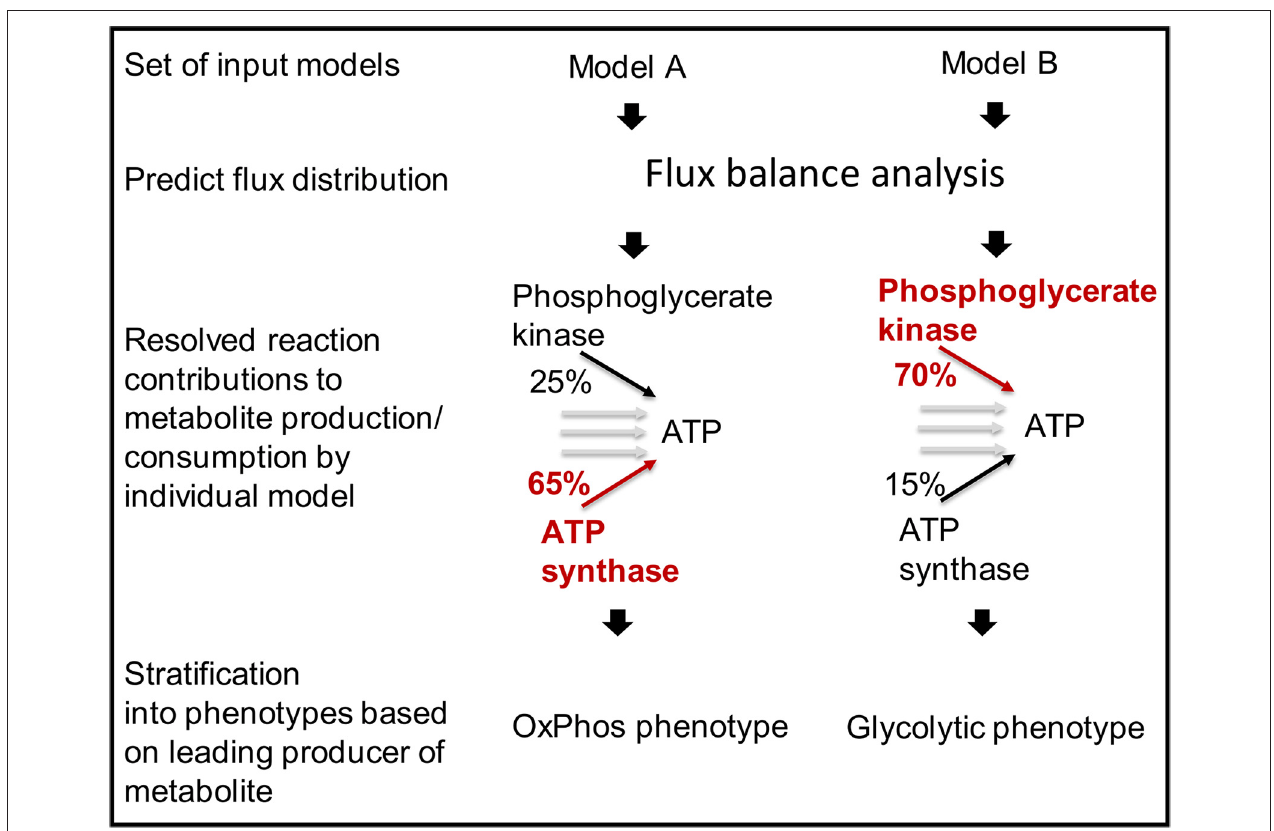
FIGURE 7 | Models can be stratified into distinct metabolic phenotypes based on the pathway that they use prevailingly.